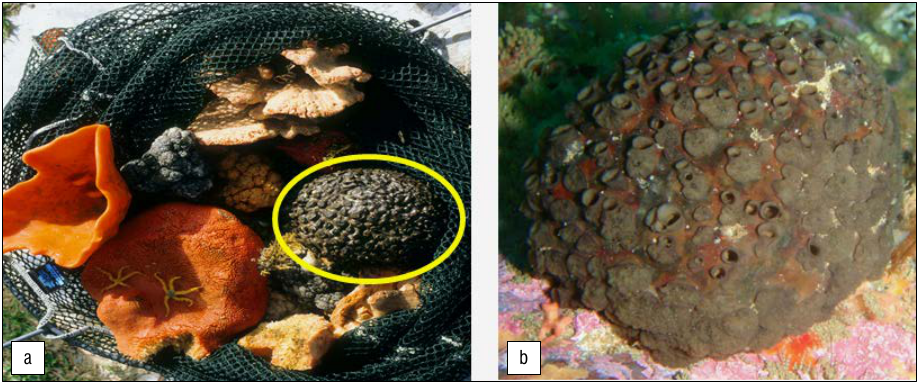
Figure 1: (a) Tsitsikamma favus (circled) in a mixed collection of sponges and soft corals from the Tsitsikamma National Park and (b) an underwater photograph of T. favus in Algoa Bay, South Africa (photos: M. Davies- Coleman and T.